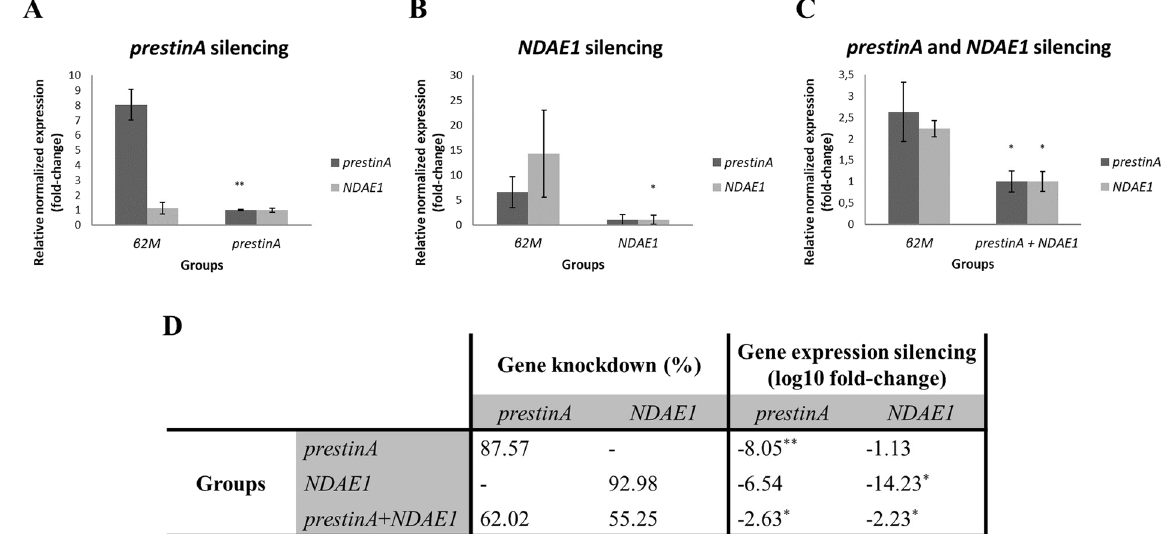
Figure 5. Results of prestinA and NDAE1 gene knockdown in Anopheles stephensi salivary glands. ( A – C ) The relative expressions of prestinA and NDAE1 were evaluated in Anopheles stephensi salivary glands with gene knockdown of prestinA , NDAE1 , and in co-silenced groups, respectively. Normalized against RPS7 , Cq values were compared between mosquitoes injected with dsRNA for the selected genes and with β 2M control dsRNA. The expression of the genes in the prestinA , NDAE1 and both silenced groups is set to 1 for a better interpretation. Statistical analyses were conducted using the Pfaff method. * P < 0.05, ** P < 0.01, *** P < 0.001. ( D ) Summary of silencing assay results. Gene expression levels and gene knockdown percentage of the treated groups.